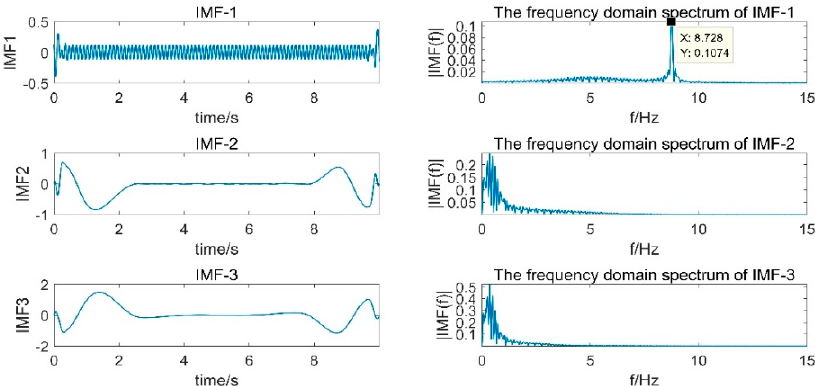
Figure 14. Part of the IMF component obtained by EMD decomposition of the displacement signal.